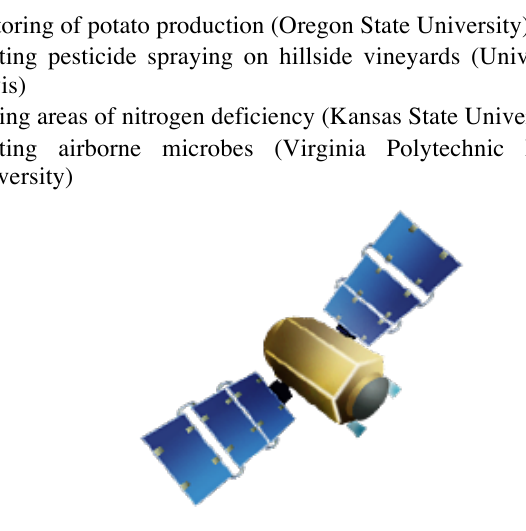
Fig. 7. Unmanned Aerial Systems offer low cost data acquisition 4